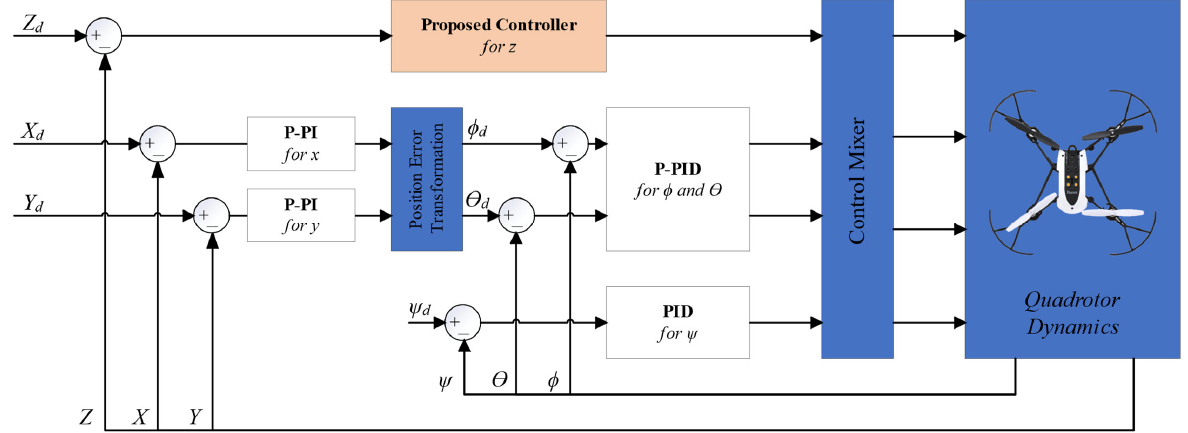
Figure 2. Block diagram of the embedded system flight controller.